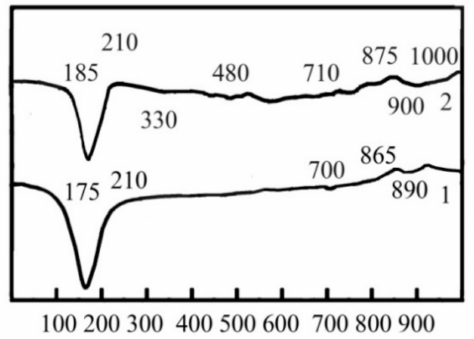
Figure 3. DTA results of the 180-day hydrated blast furnace cement mixed with sea water and containing, as minor additional constituents, 1—Na 2 CO 3 and 2—Na 2 CO 3 in combination with calcium aluminate